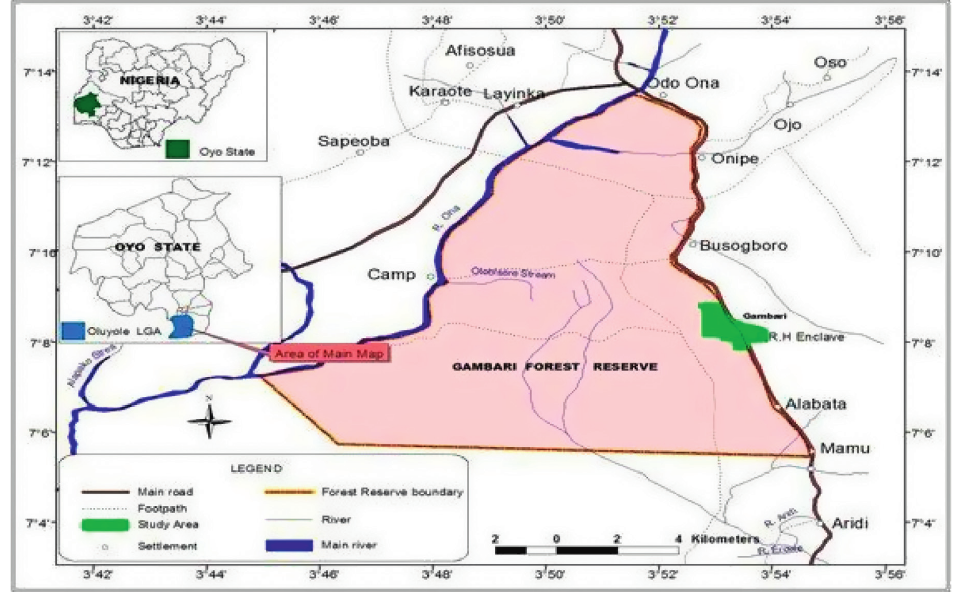
Figure 2: Map of the study area within Oyo State and Nigeria.